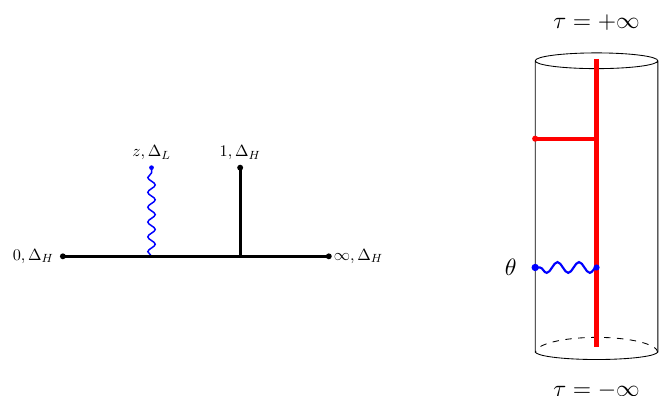
Figure 1 . The 4-point HHHL block and its holographically dual realization in the three dimensional bulk (a rigid cylinder). The red lines inside the cylinder visualize the 3-point function of heavy operators that created this conical defect geometry. The wavy blue line denotes the perturbative operator propagating in the O L